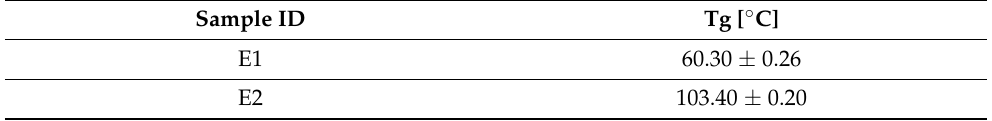
Table 2. Tg results obtained from DMA for the two investigated curing cycles (E1 vs.